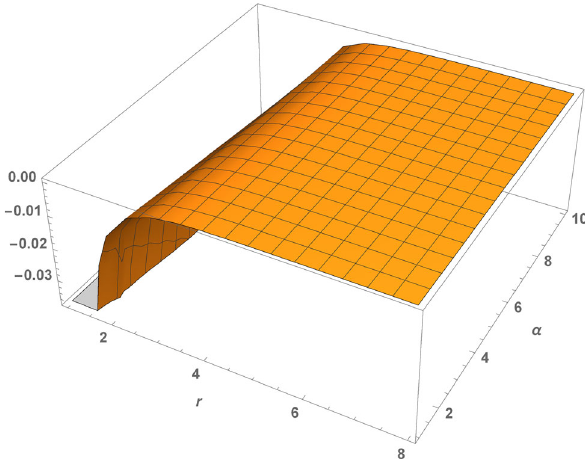
Fig. 6 NEC, ρ + p t ≥ 0, for λ = − 35 and different α